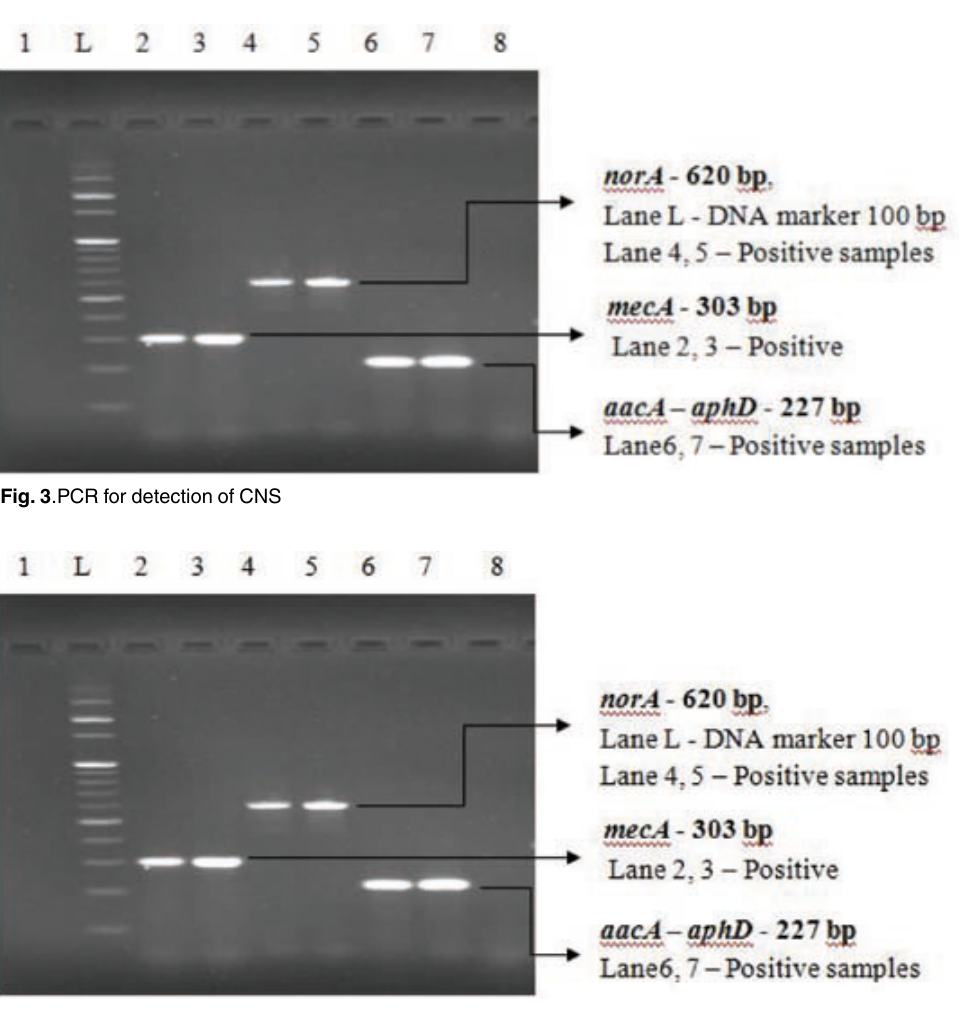
Fig. 4 .PCR for detection of mecA, norA and aacA-aphD in